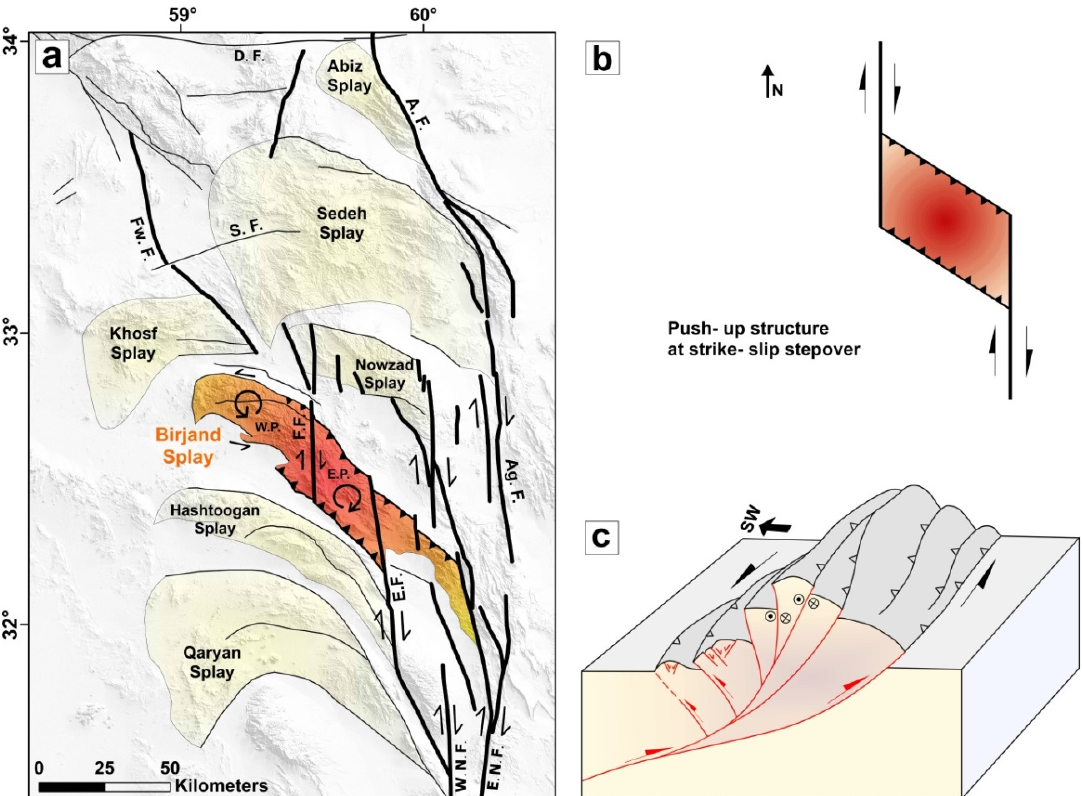
Figure 19. The proposed tectonic model for the north of the East Iran orogen. ( a ) The northern splays of the N-S right-lateral fault terminations of the Neh fault system. ( b ) The east Birjand splay (EBS) as a push-up structure in the restraining bend of the Esmaeilabad fault (EF) and the Fanud fault (FF). ( c ) A schematic model for the west Birjand splay (WBS), which shows the E-W left-lateral faulting with the N-S reverse transition. Abbreviations: D. F.= Dasht-e Bayaz fault; A. F. = Abiz fault; S. F. = Sedeh fault; Fw. F. = Ferdows fault; Ag. F. = Abegarm fault; E. N. F. = East Neh fault; W. N. F. = West Neh fault; STZ = Shekarab transpressional